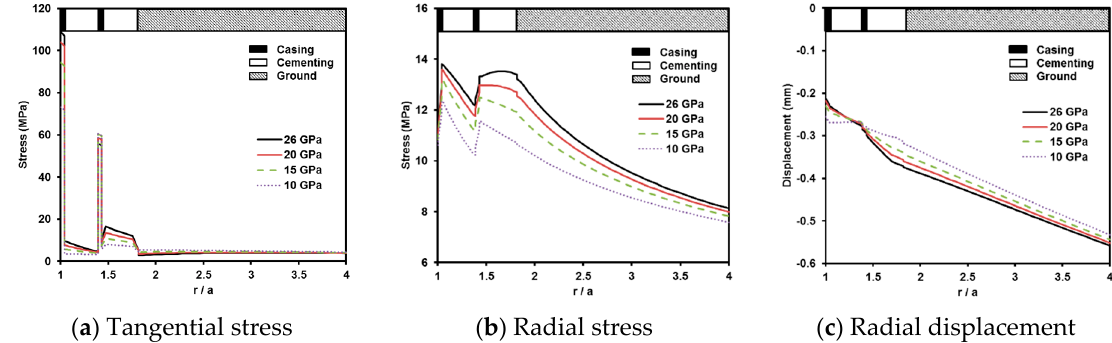
Figure 9. Stress and displacement at 200 m with variation of Young’s modulus of the cementing component.